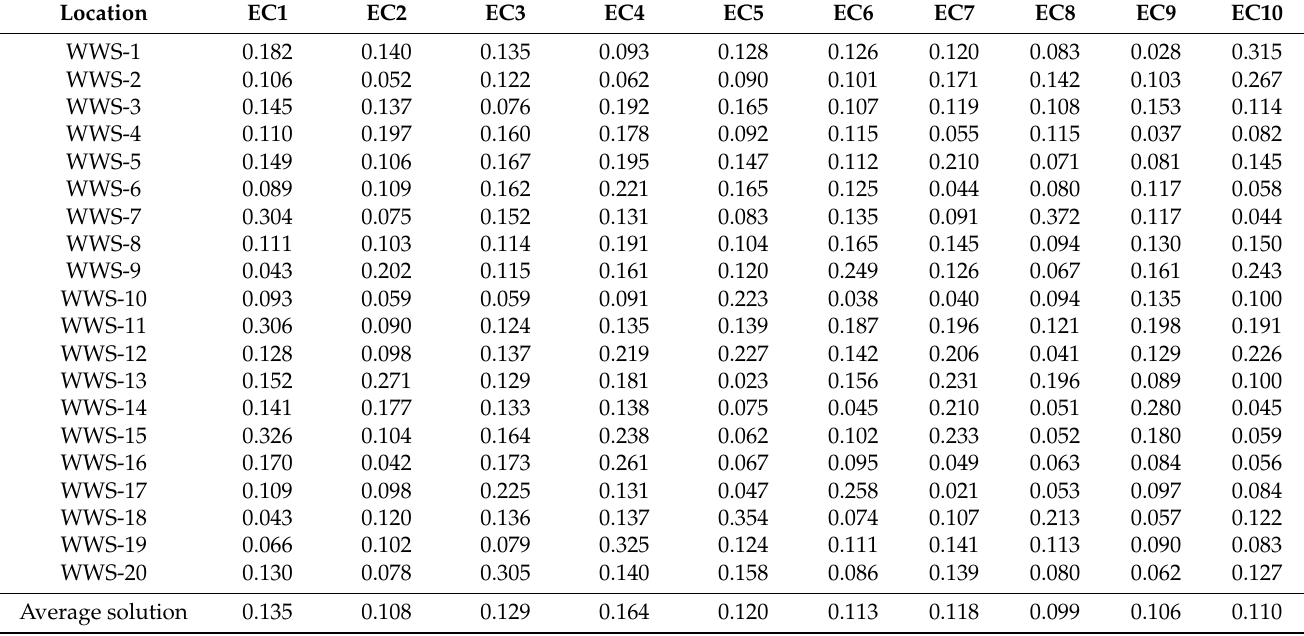
Table A8. Defuzzied decision matrix and average